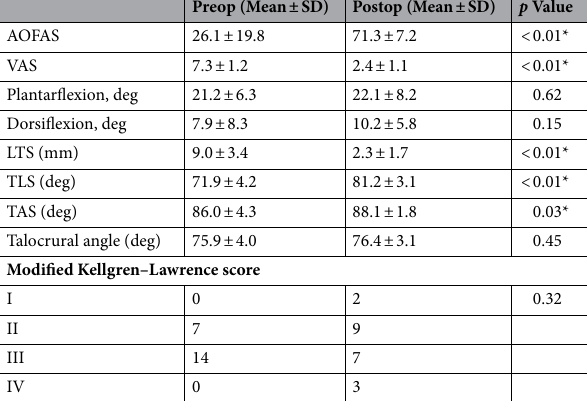
Table 1. Clinical and radiological